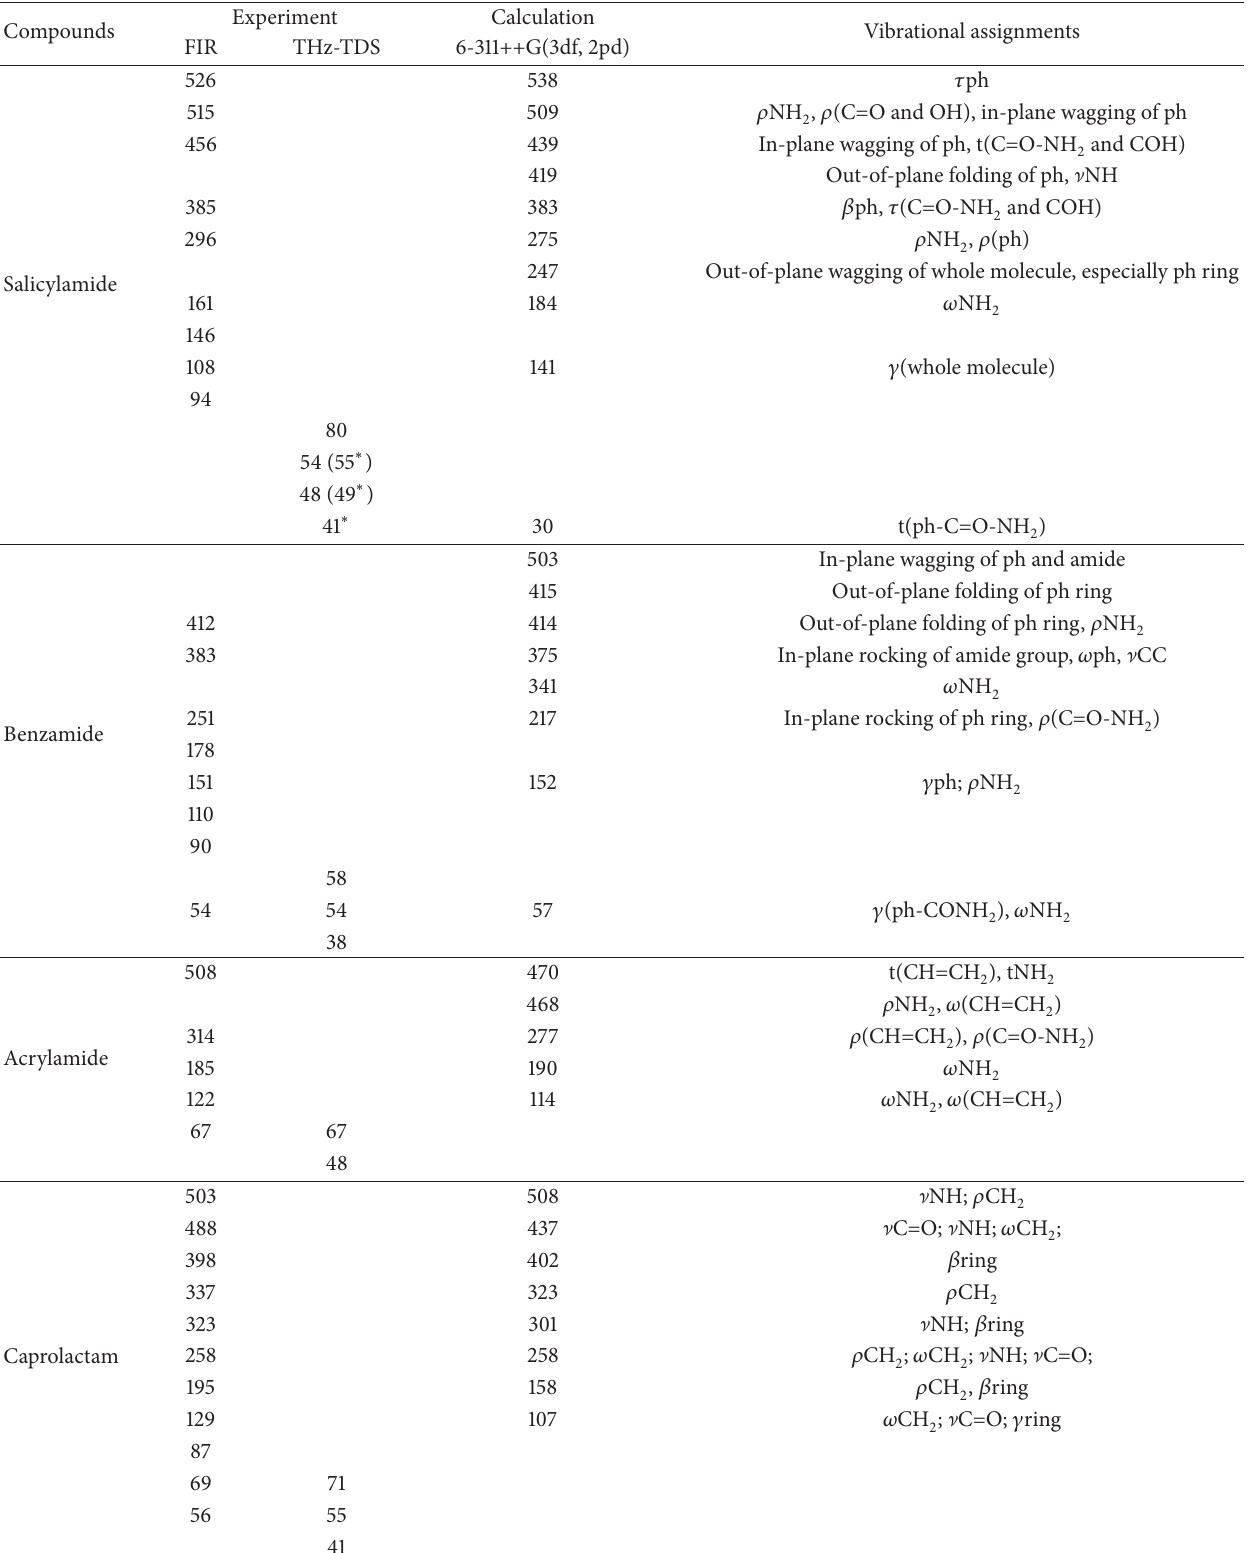
Table 1: Calculated and experimental vibrational frequencies for salicylamide, benzamide, acrylamide, caprolactam, and sulfanilamide (cm − 1 ) a